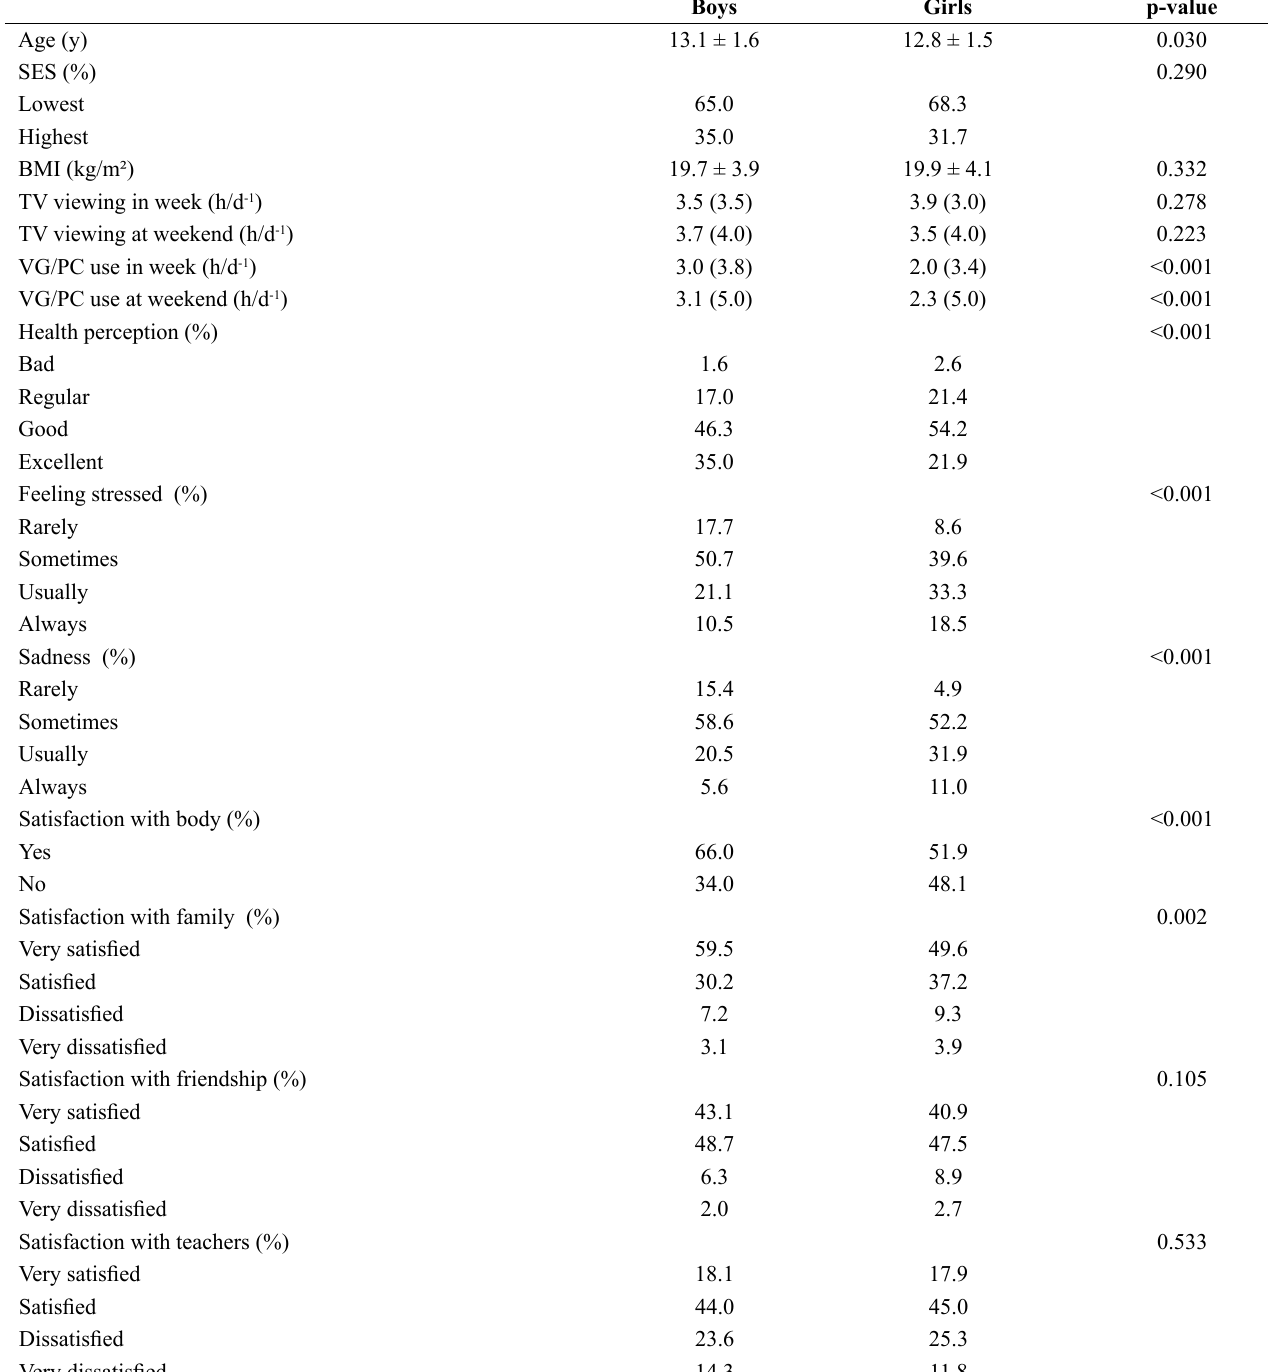
Table 1. Characteristics of the sample according to gender (Londrina 2011, Brazil; n =